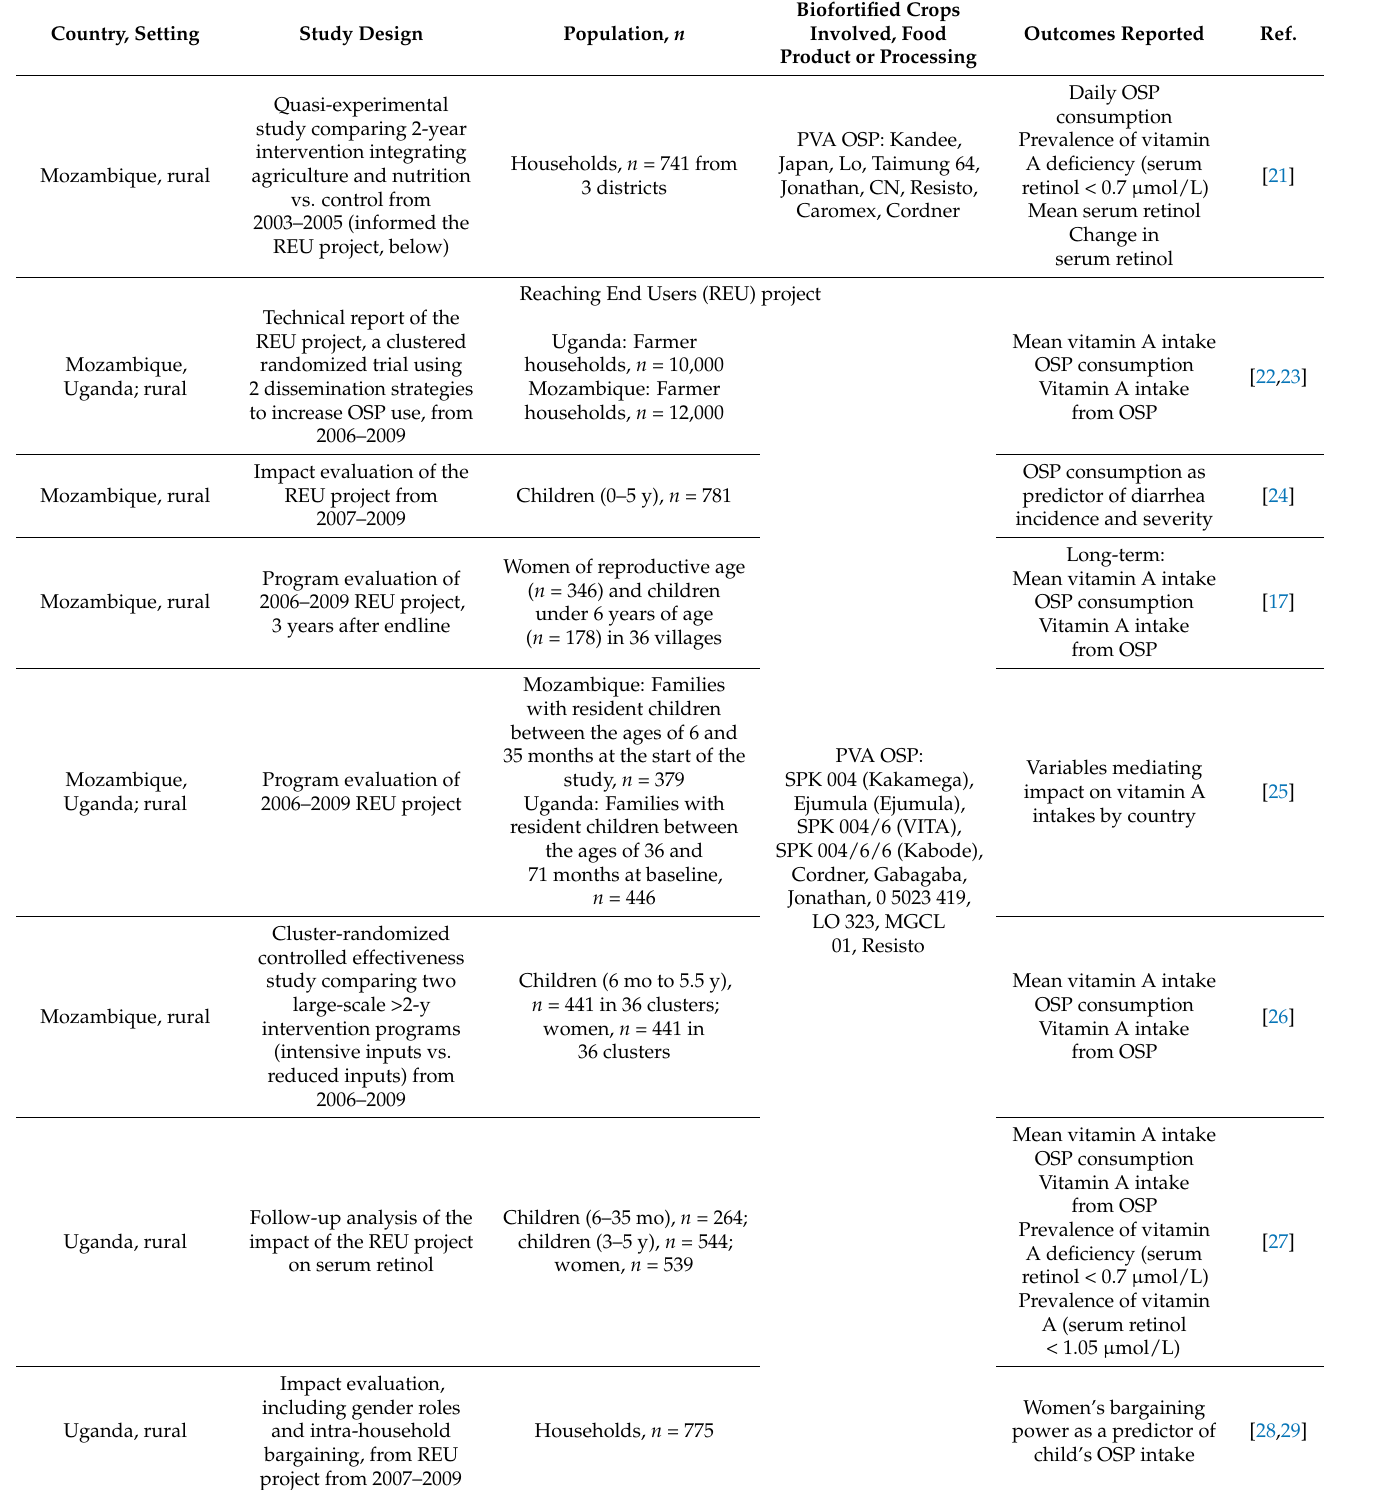
Table 6. Characteristics of included studies for Impact Pathway 4, Farmer Household